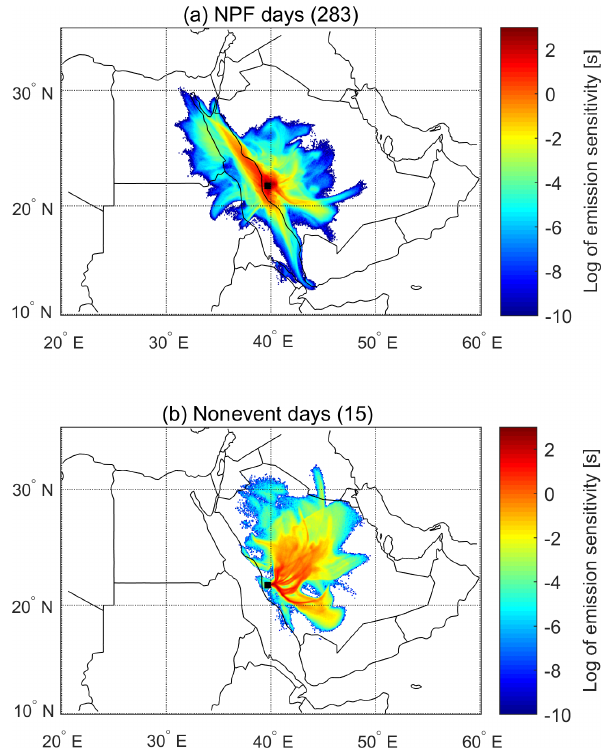
Figure 4. Average 24h emission sensitivity for air masses arriving at Hada Al Sham at 10:00LT for (a) NPF days and (b) nonevent days. The arrival time of the air masses is chosen to represent the time when new particle formation is typically taking place on NPF days (see Fig.